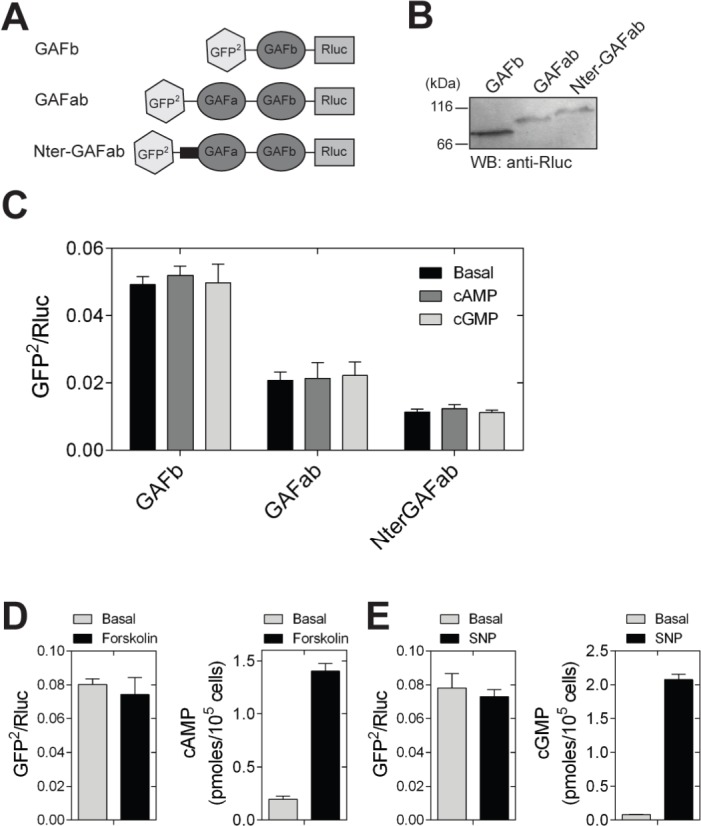
Ligand binding to the GAFb domain does not result in structural changes at the N- and C-termini.(A) Diagrammatic representation of various BRET-based sensor constructs used in the study. [B] Western blot analysis using anti-Rluc polyclonal antibody to confirm the expression of GAFb, GAFab and NterGAFab sensor constructs. Expected molecular weight of the GAFb, GAFab and NterGAFab sensor constructs are 82.7, 103.8 and 112.7 kDa, respectively. (C) Lysates prepared from cells expressing the PDE5 GAFa(F163A), GAFb, GAFab and NterGAFab sensor constructs were incubated in the absence or presence of 1 mM cAMP or cGMP at 37 °C for 10 min followed by BRET measurement. (D) and (E) HEK293T cells transfected with the GAFb sensor were treated with 100 µM of either forskolin (5 min) (D) or SNP (2 min) (E) at 37 °C and BRET was determined. Intracellular levels of cAMP or cGMP were determined using a parallel set of cells. Data shown are mean ± S.E.M from a representative experiment performed in triplicate.